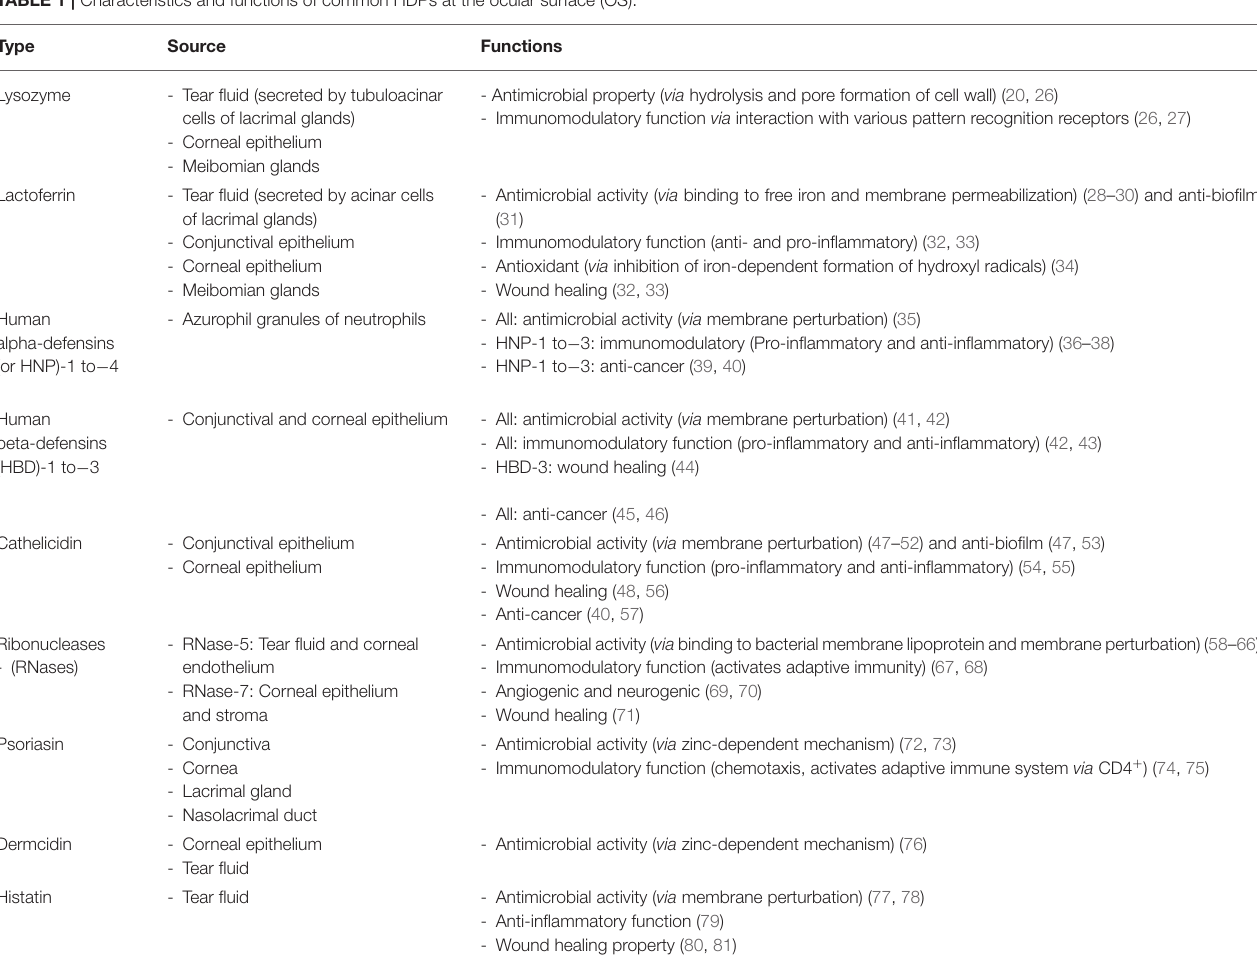
TABLE 1 | Characteristics and functions of common HDPs at the ocular surface